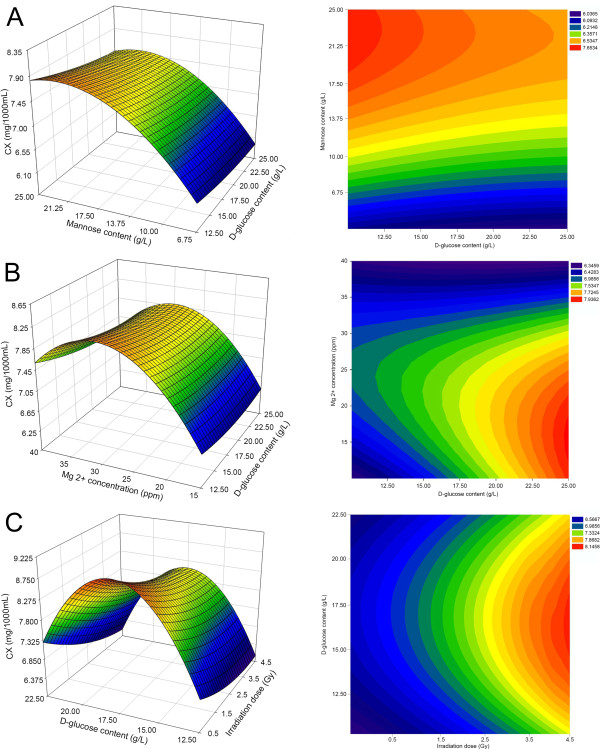
Response surface curve (Left) and Contour plot (Right) of CX production by D. natronolimnaea svgcc1.2736 showing mutual interactions between showing mutual interactions between (A) D-glucose and mannose, (B) D-glucose and Mg2+, (C) 12C6+-ions irradiation dose and D-glucose. Other variables, except for those presented here, were maintained at zero.